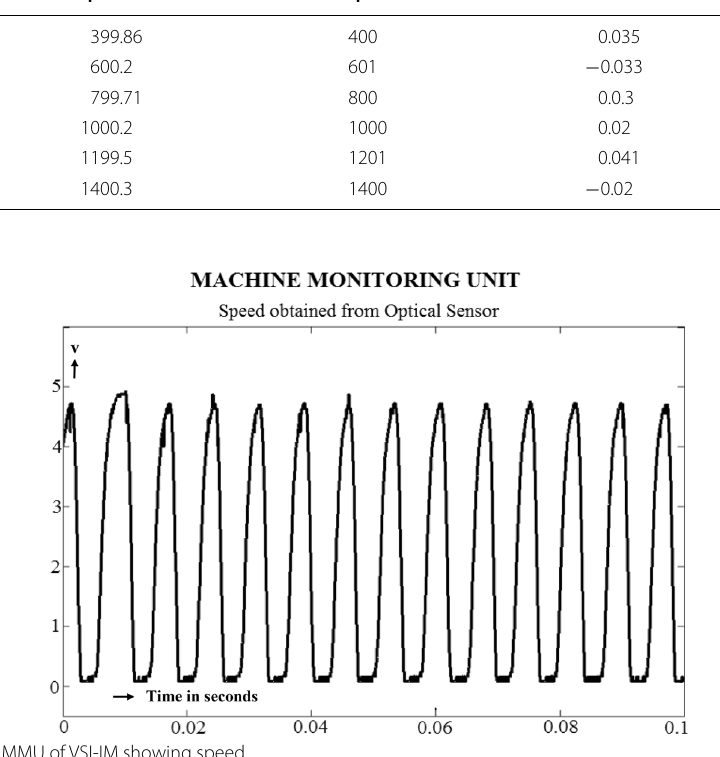
Fig. 20 MMU of VSI-IM showing